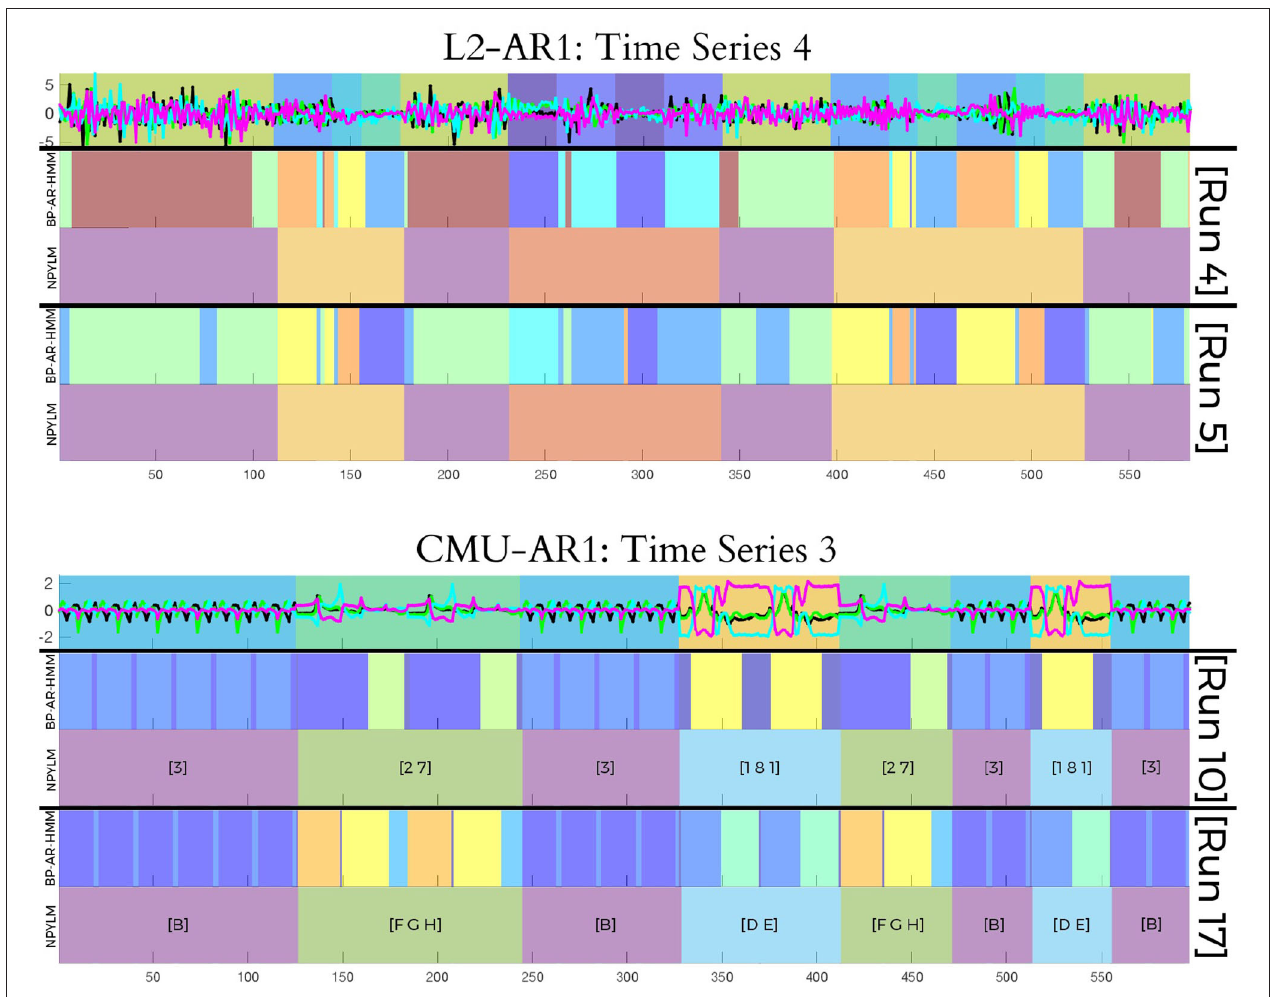
FIGURE 8 | Plot of the first four dimensions of the input data and example segmentation results using our proposed method, obtained from two different runs. (Top) Toy data, with result from L2-AR1 . (Bottom) CMU motion data, with result from CMU-AR1